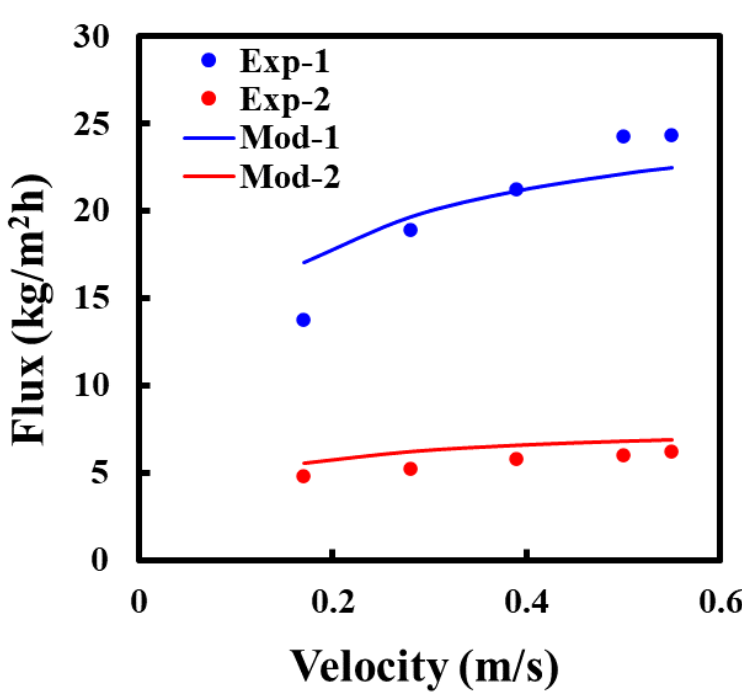
Figure A1. DCMD model validation (experimental data can be retrieved from [17]).